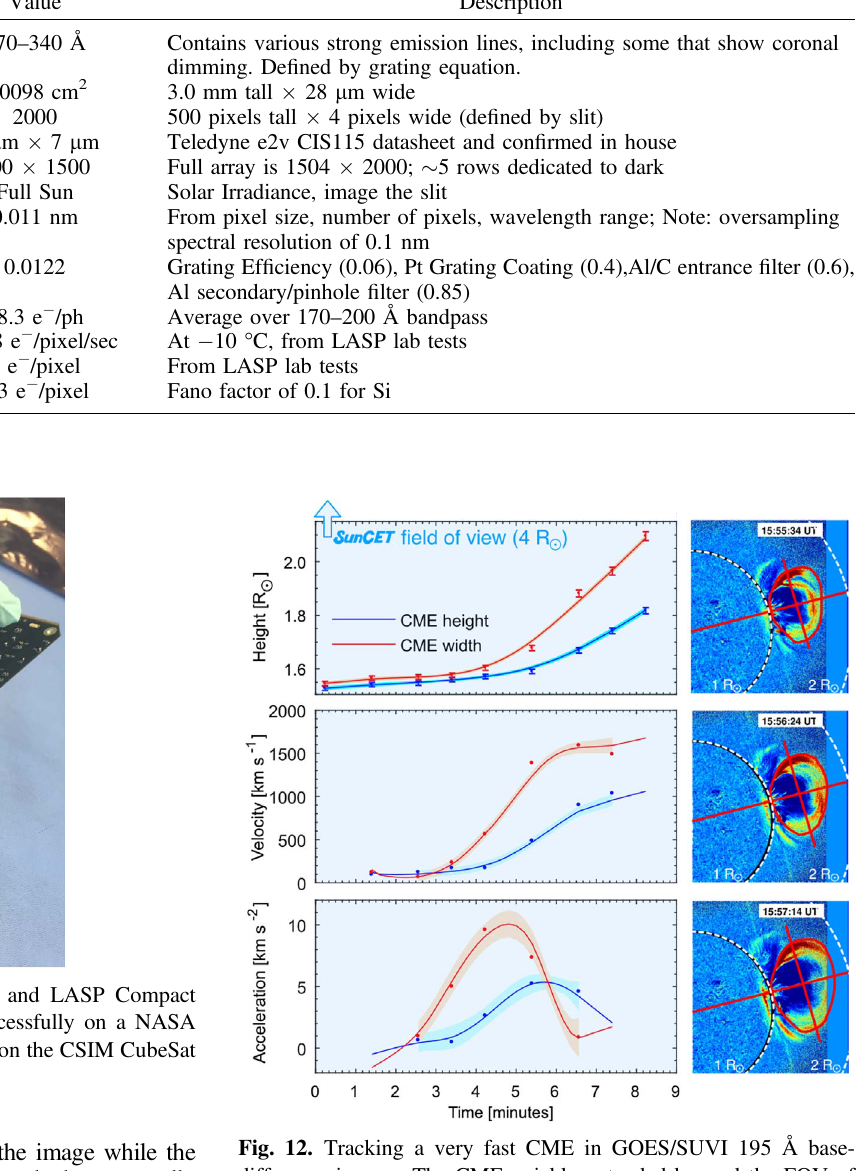
Table 5. SunCET spectrograph instrument parameters needed to calculate SNR. Instrument parameter